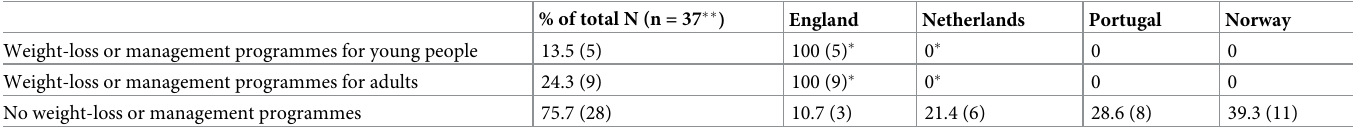
Table 4. Frequency of weight management programmes delivered in professional football clubs in four European countries.